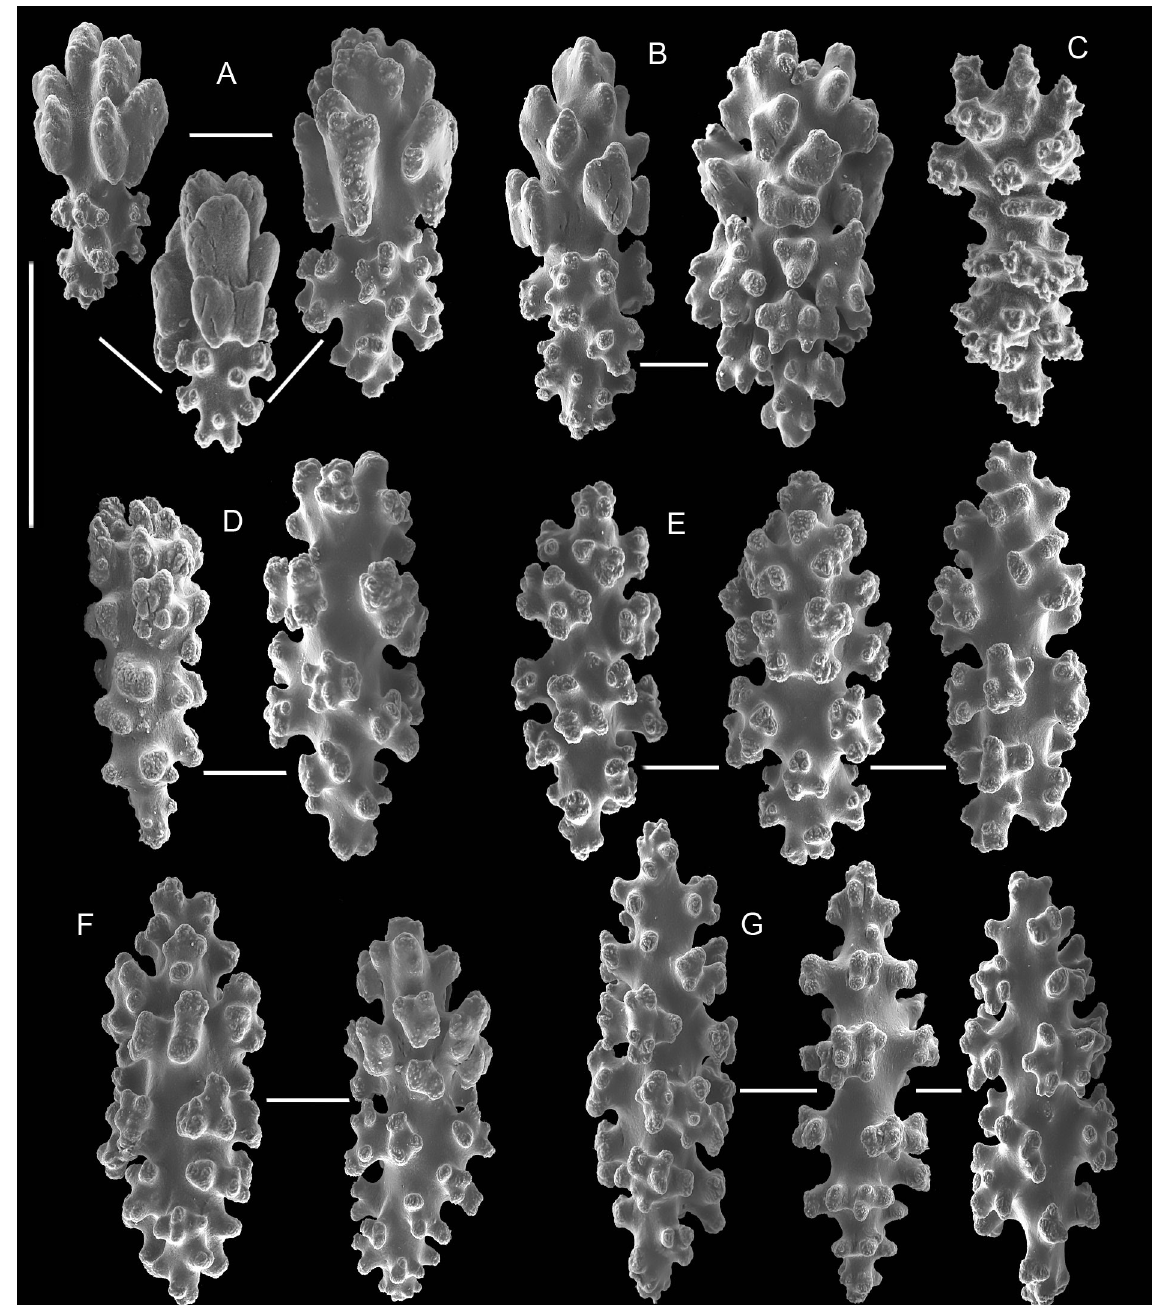
Fig. 3. Calcigorgia matua sp. nov., holotype (MIMB 20722), sclerites from the polyp body wall. A . Clubs with a head consisting of leafy processes. B . Longer clubs with staggered leafy processes on a head. C . Warty clubs. D . Club-like spindles ornamented with well-developed warts. E . Capstans ornamented with girdled warts. F . Ovals. G . Spindles. Scale bar: 0.1